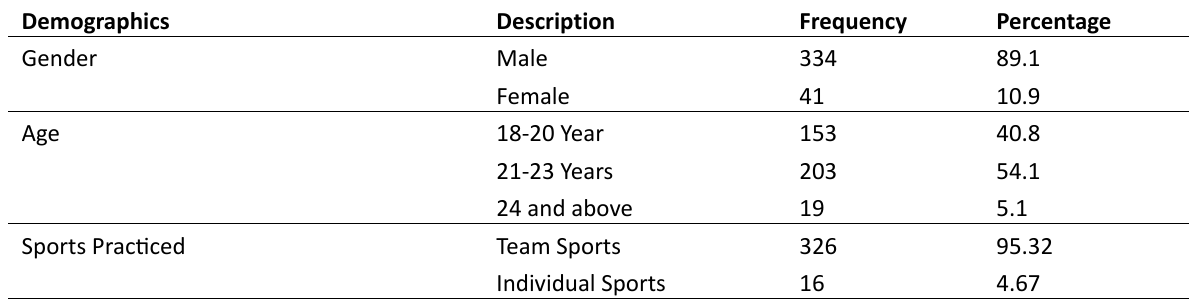
Table 2. Showing views of the athletes regarding the role of sports in the development of decision-making skills